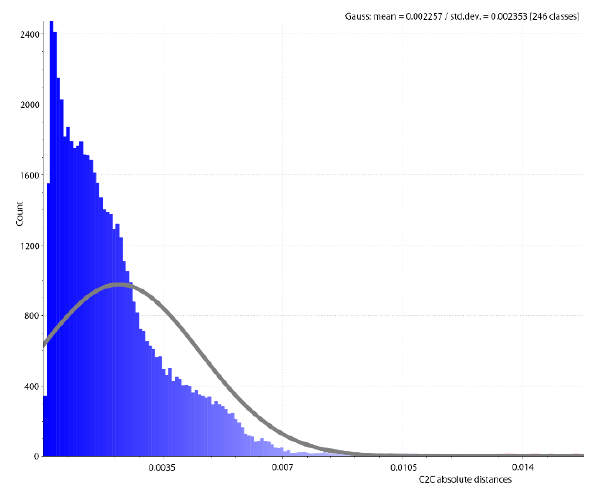
Figure 9. C2C absolute distance between TLS and photogrammetric point clouds with indication of the Gauss distributor